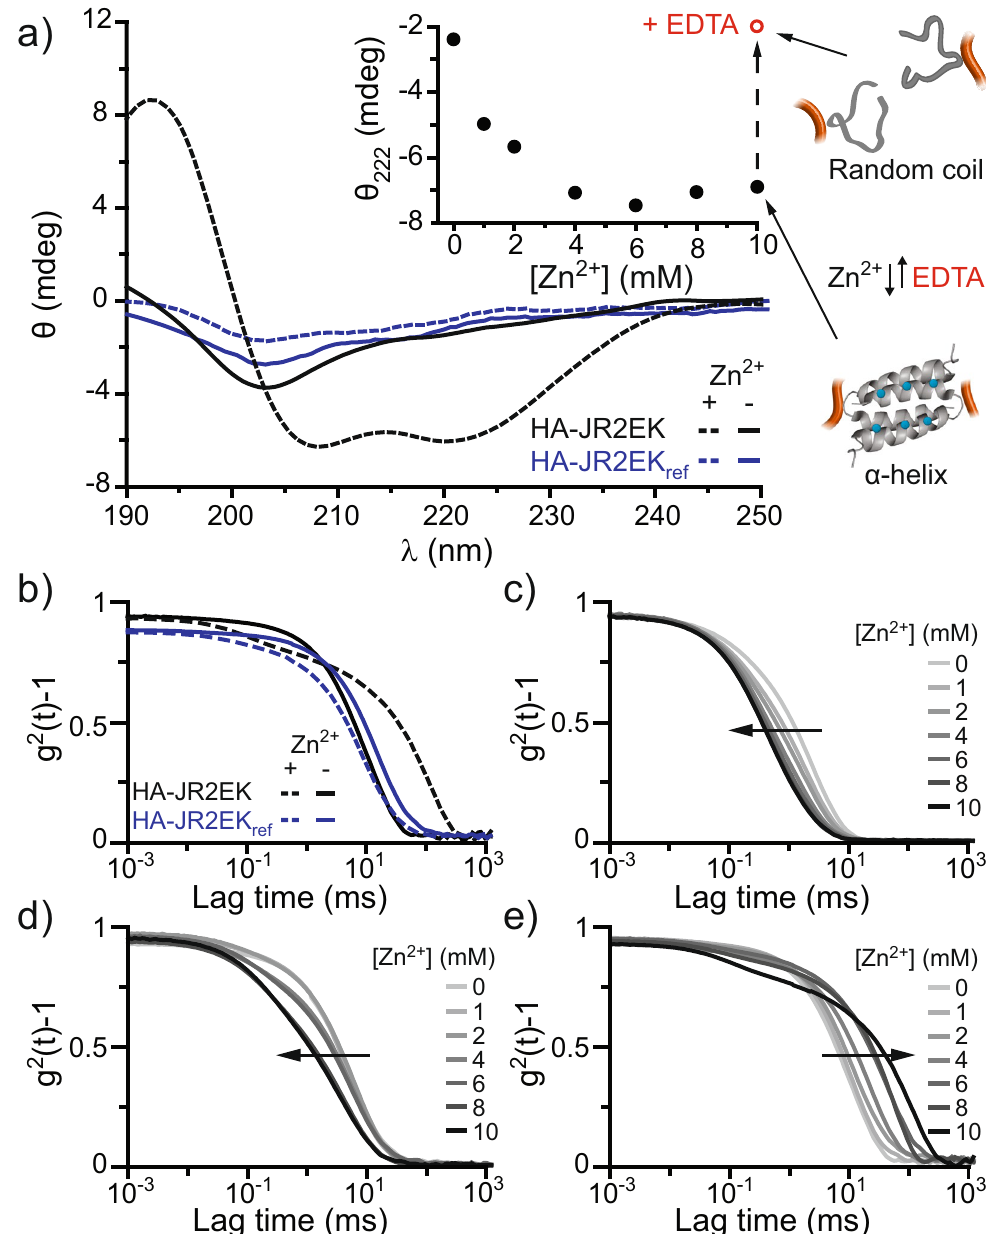
Figure 2. CD and DLS characterization of hydrogel formation induced by Zn 2 + . CD spectra of 0.1 wt % HA- JR2EK and HA-JR2EK ref with and without 10 mM Zn 2 + . Inset: Increase in helicity of 0.1 wt % HA-JR2EK (at 222 nm) as a function of increasing [Zn 2 + ]. The peptide unfolded upon addition of 10 mM EDTA. ( b ) Normalized autocorrelation functions for 1.0 wt % HA-JR2EK and HA-JR2EK ref with and without 10 mM Zn 2 + . Normalized autocorrelation functions for 0.1 ( c ), 0.5 ( d ) and 1.0 ( e ) wt % HA-JR2EK with increasing [Zn 2 +